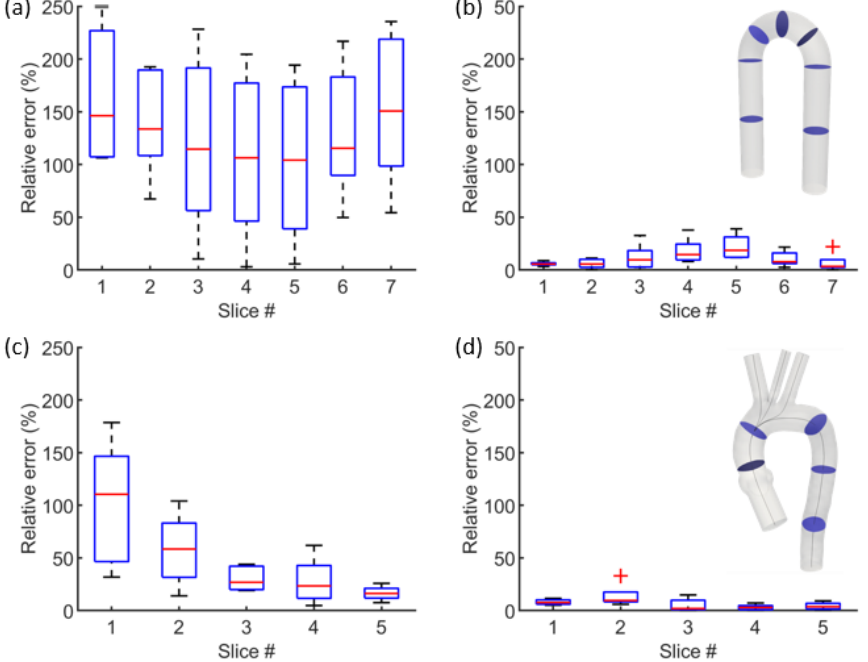
Figure 10. Percentage difference between estimated E PWV and assigned E ( a , b ) and percentage difference between estimated E χ and assigned E value ( c , d ) value at every slice for M 1 (top panel) and M 2 (bottom